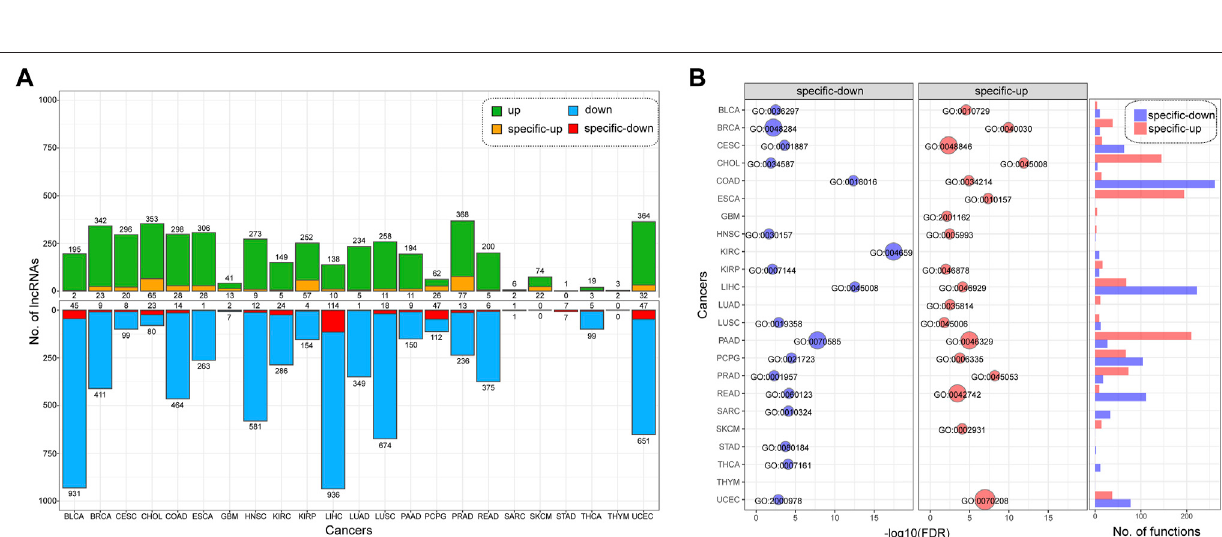
Frontiers in Cell and Developmental Biology |